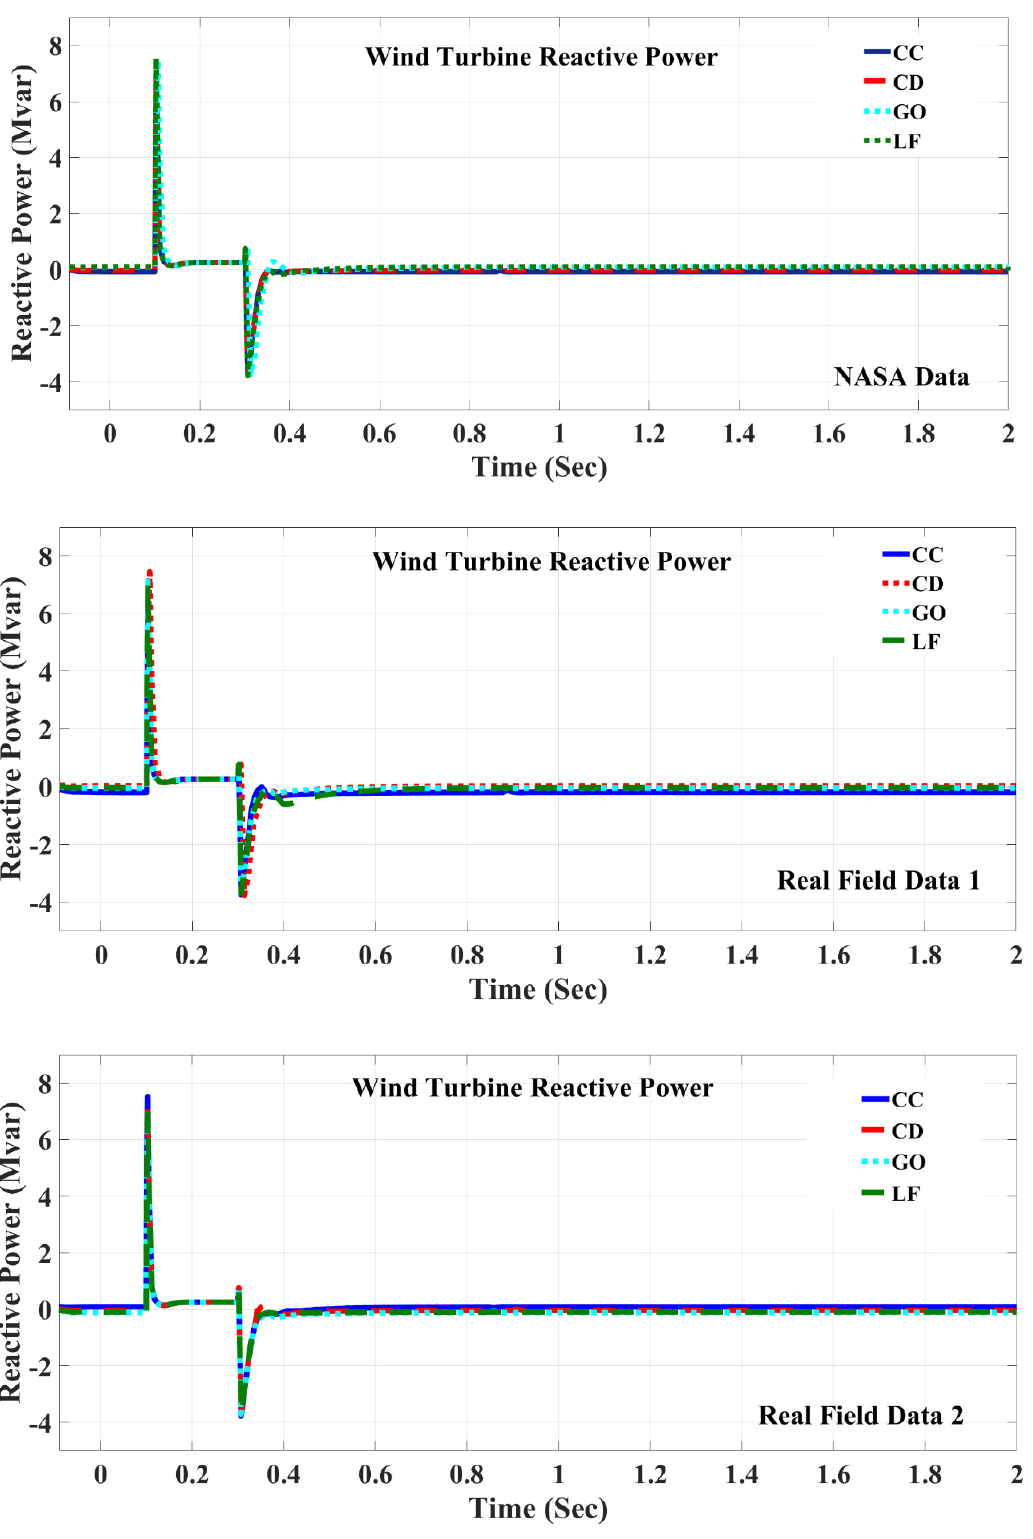
Figure 12. Reactive power responses of wind turbine generator at Bus 1 for four dispatch strategies.